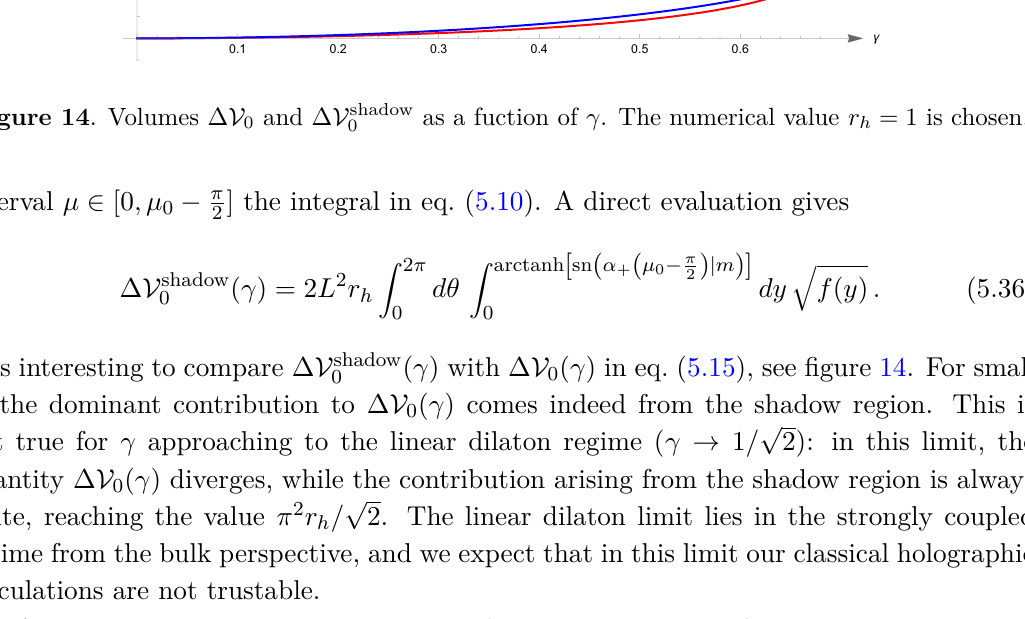
Figure 14 . Volumes ∆ V 0 and ∆ V shadow